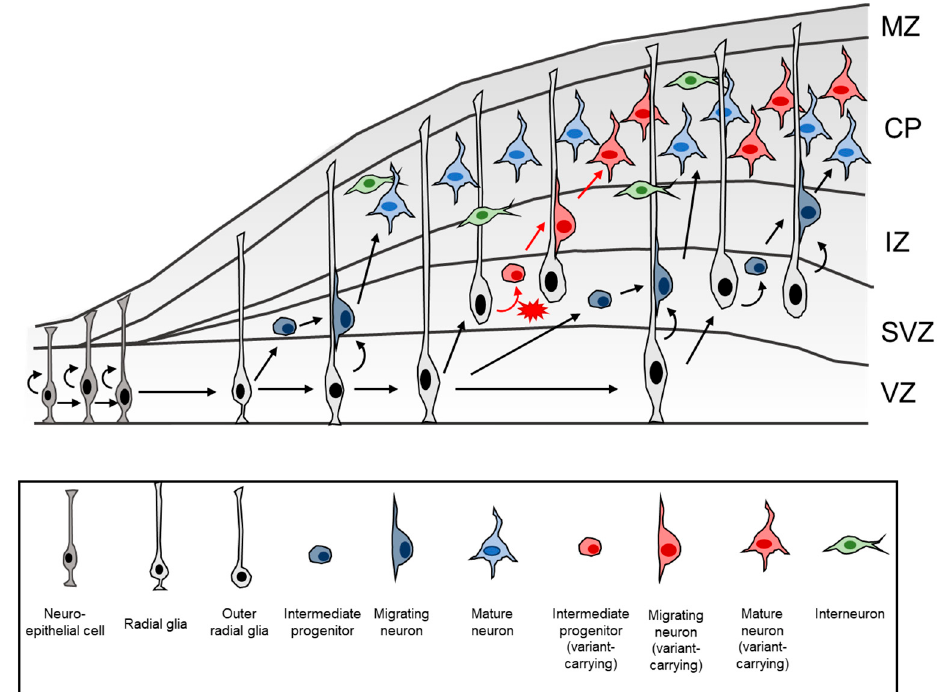
Figure 4. Cortical development and hypothetical occurrence of somatic variant in a subset of brain cells during neurogenesis. During cortical development, neuroepithelial cells undergo symmetric division to generate more progenitors. Neuroepithelial cells then convert into radial glia, which are able to divide asymmetrically to generate intermediate progenitor cells, migrating neurons, and more radial glia. Intermediate progenitor cells can divide symmetrically to generate clones of neurons. Neurons migrate radially along radial glia to the designated cortical layer to become mature neurons. Radial glia also give rise to outer radial glia, which also have the potential to undergo asymmetric division. In a hypothetical scenario, a somatic variant may occur in intermediate progenitor cells during the process of proliferation (red). These variant-carrying intermediate progenitor cells give rise to neurons that similarly harbour the variant. Neurons of a different clonal origin can continue to be produced normally without somatic variant (blue). This process results in a mixture of brain cells in which only a proportion of cells may carry the somatic variant. Furthermore, interneurons migrate tangentially from the ganglionic eminence (not shown), astrocytes, oligodendrocytes and microglial cells further complicate the clonal diversity in any given cortical